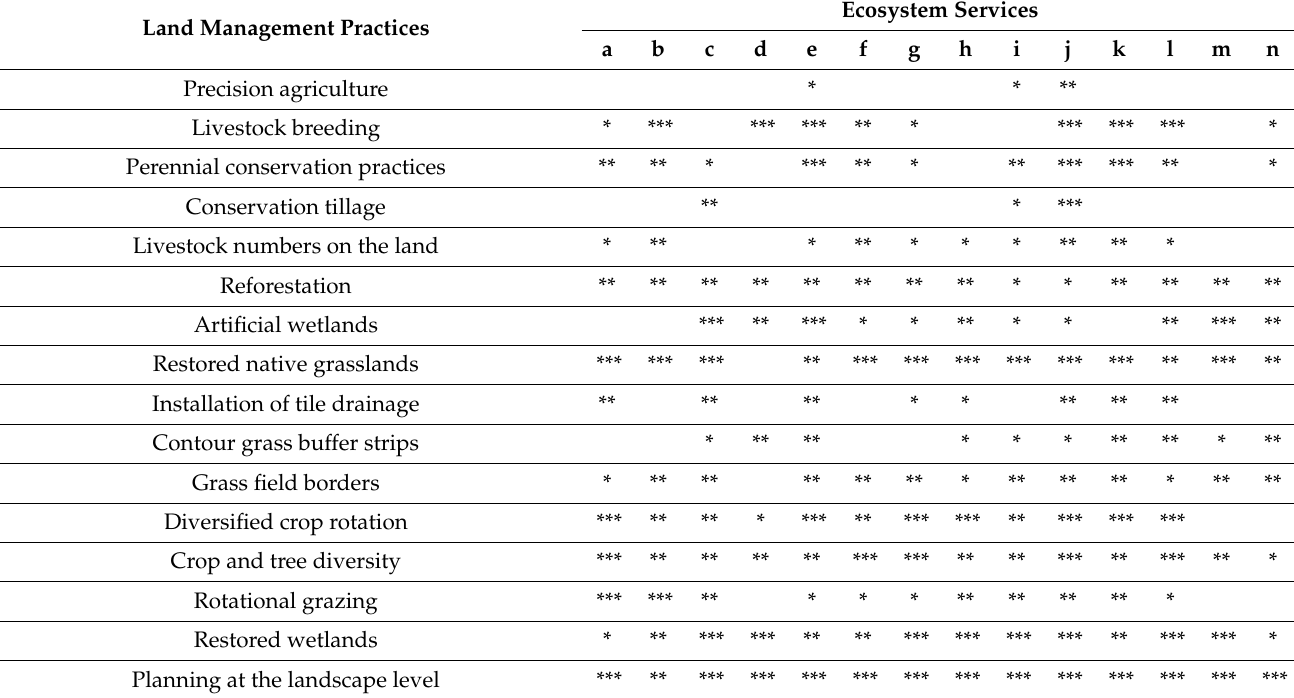
Table 2. Relationship between land management practices and ecosystem services for Prespa Lakes watershed. Important links are denoted by a triple asterisk (***), moderate by two asterisks (**), and relatively less important links by a single asterisk